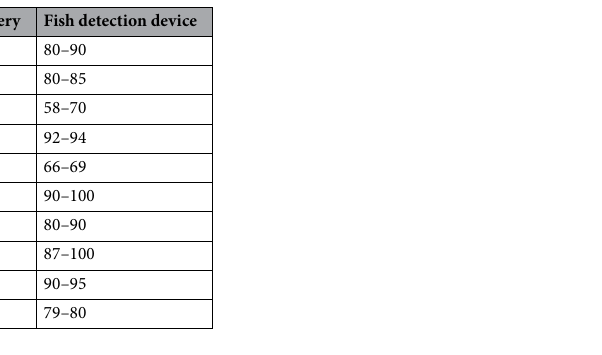
Table 12. Scoring result(Fishing